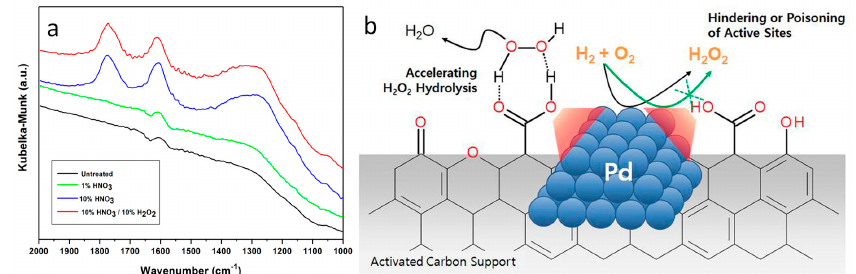
Figure 21. ( a ) DRIFTS-IR spectra or the surface-modified activated carbon. ( b ) Illustration of the unfavourable effect of carboxyl groups in accelerating H 2 O 2 hydrolysis as well as hindering or poisoning the active metal sites. Reprinted from J. Catal., 365, S. Lee, H. Jeong, Y.-M. Chung, Direct synthesis of hydrogen peroxide over Pd/C catalyst prepared by selective adsorption deposition method, 125–137, Copyright (2018), with permission from Elsevier.